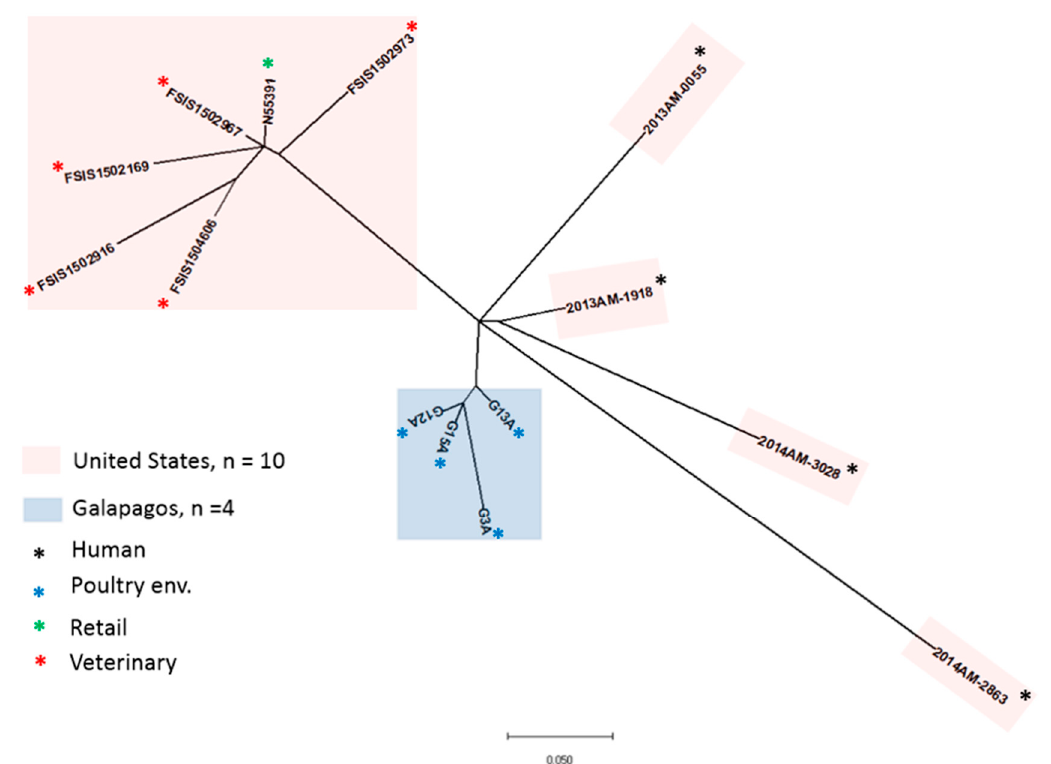
Figure 2. Phylogenetic analysis of Salmonella Infantis isolates from the Galapagos and the United States using single nucleotide polymorphism. Relationship among S. Infantis isolates from the Galapagos ( n = 4) and the United States ( n = 10; [25]) were analyzed by ParSNP analysis to identify single-nucleotide changes following a rapid core-genome multi-alignment of the genome